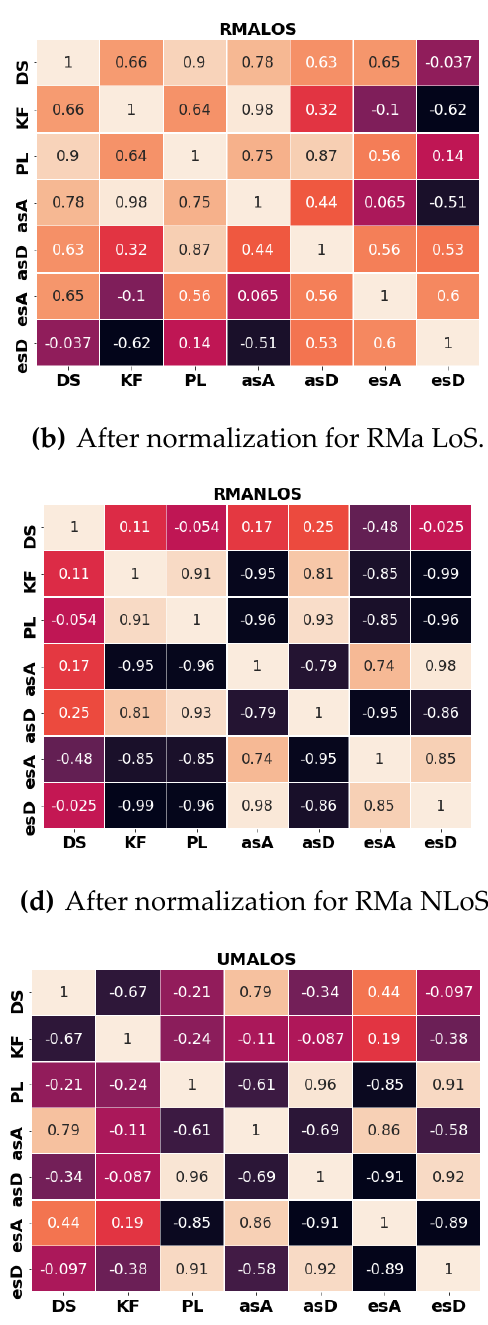
(e) Before normalization for UMa LoS. (f) After normalization for UMa LoS. Figure 5. Cont